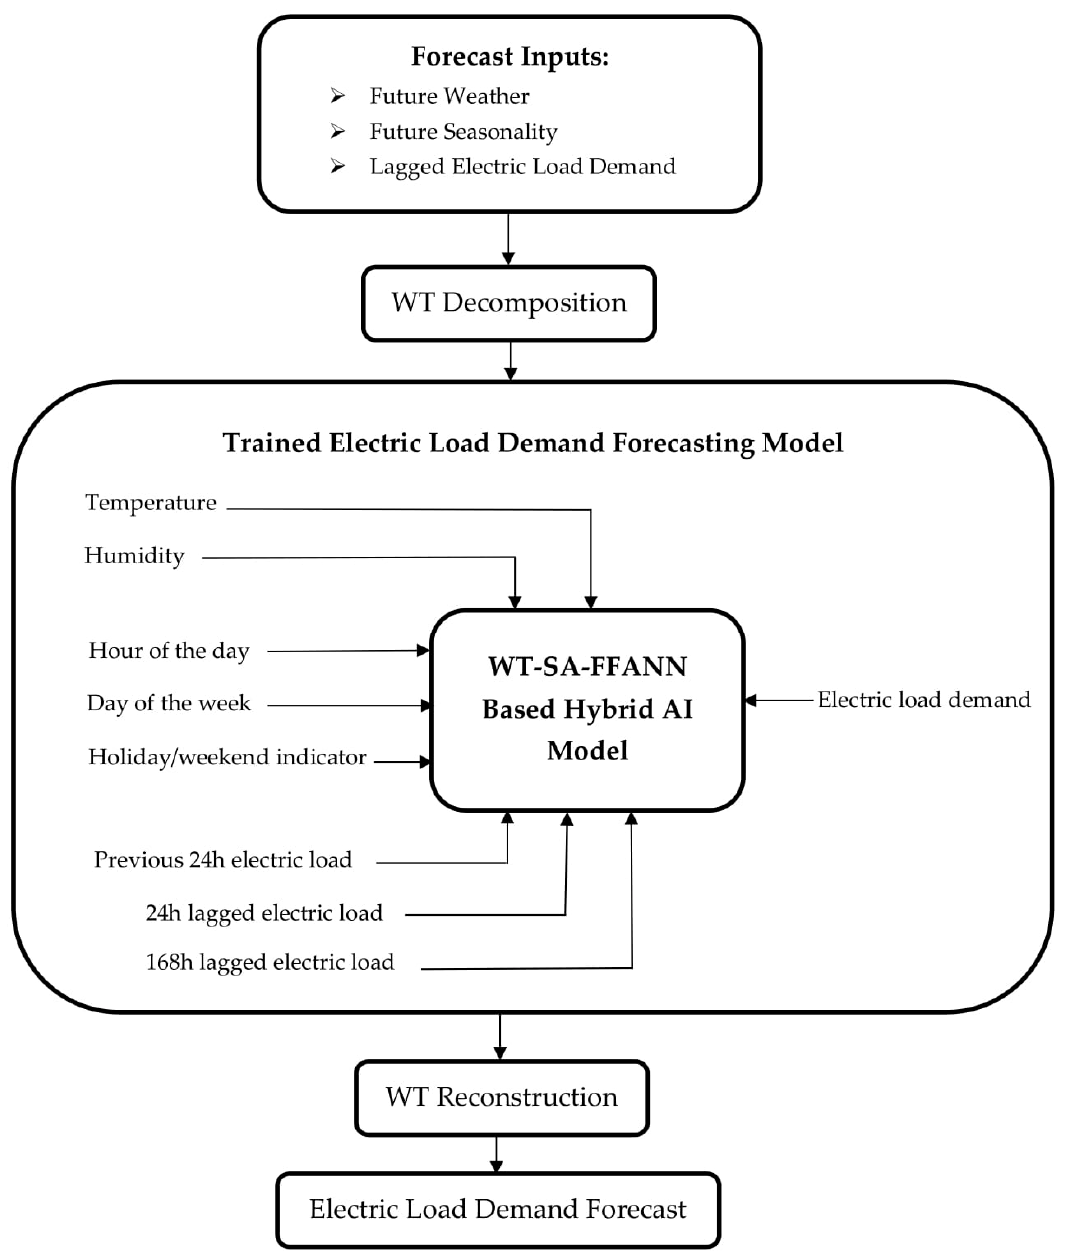
Figure 1. Schematic for the devised WT-SA-FFANN based integrated electricity demand forecasting approach for microgrids.